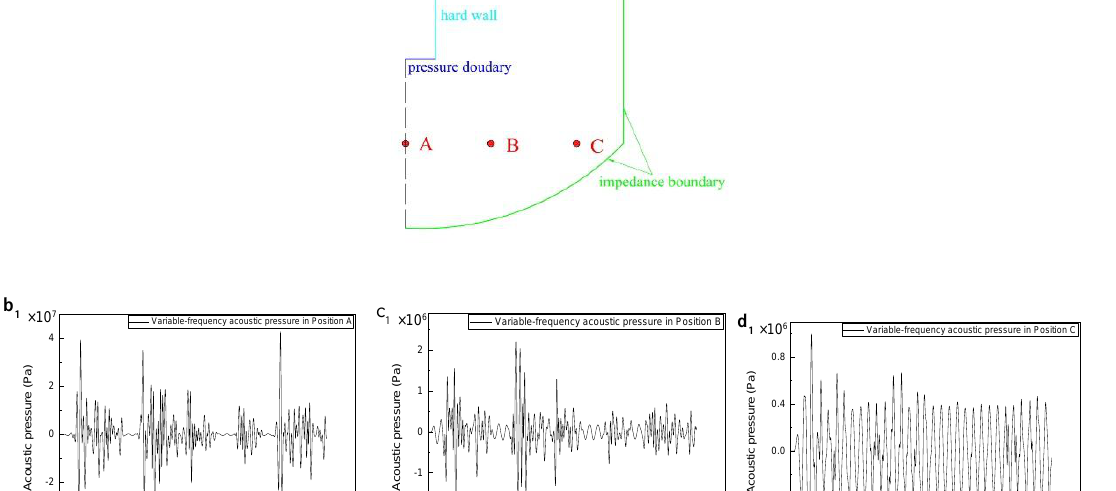
Table 2. Material properties and some critical model parameters.